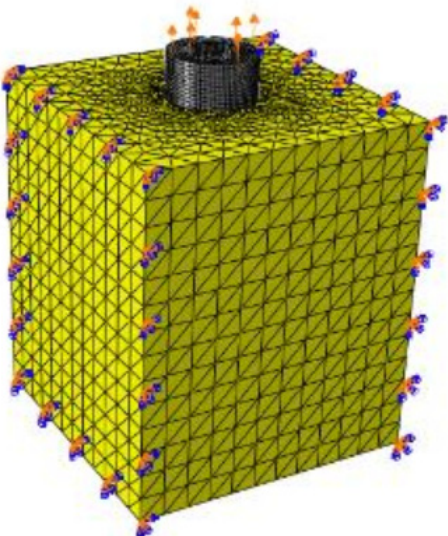
Figure 7. Boundary conditions of pull-out simulation.